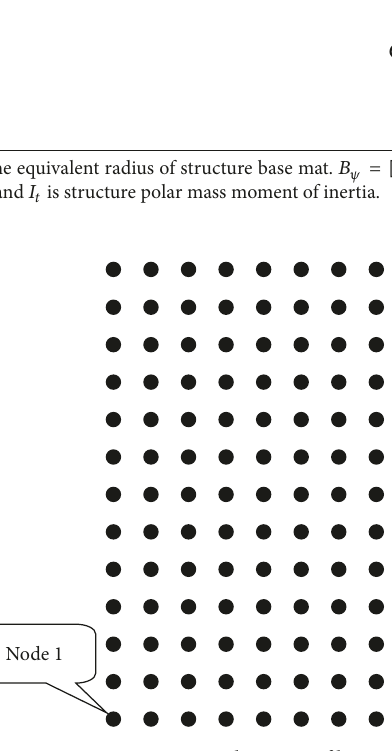
Figure 6: Plan view of base